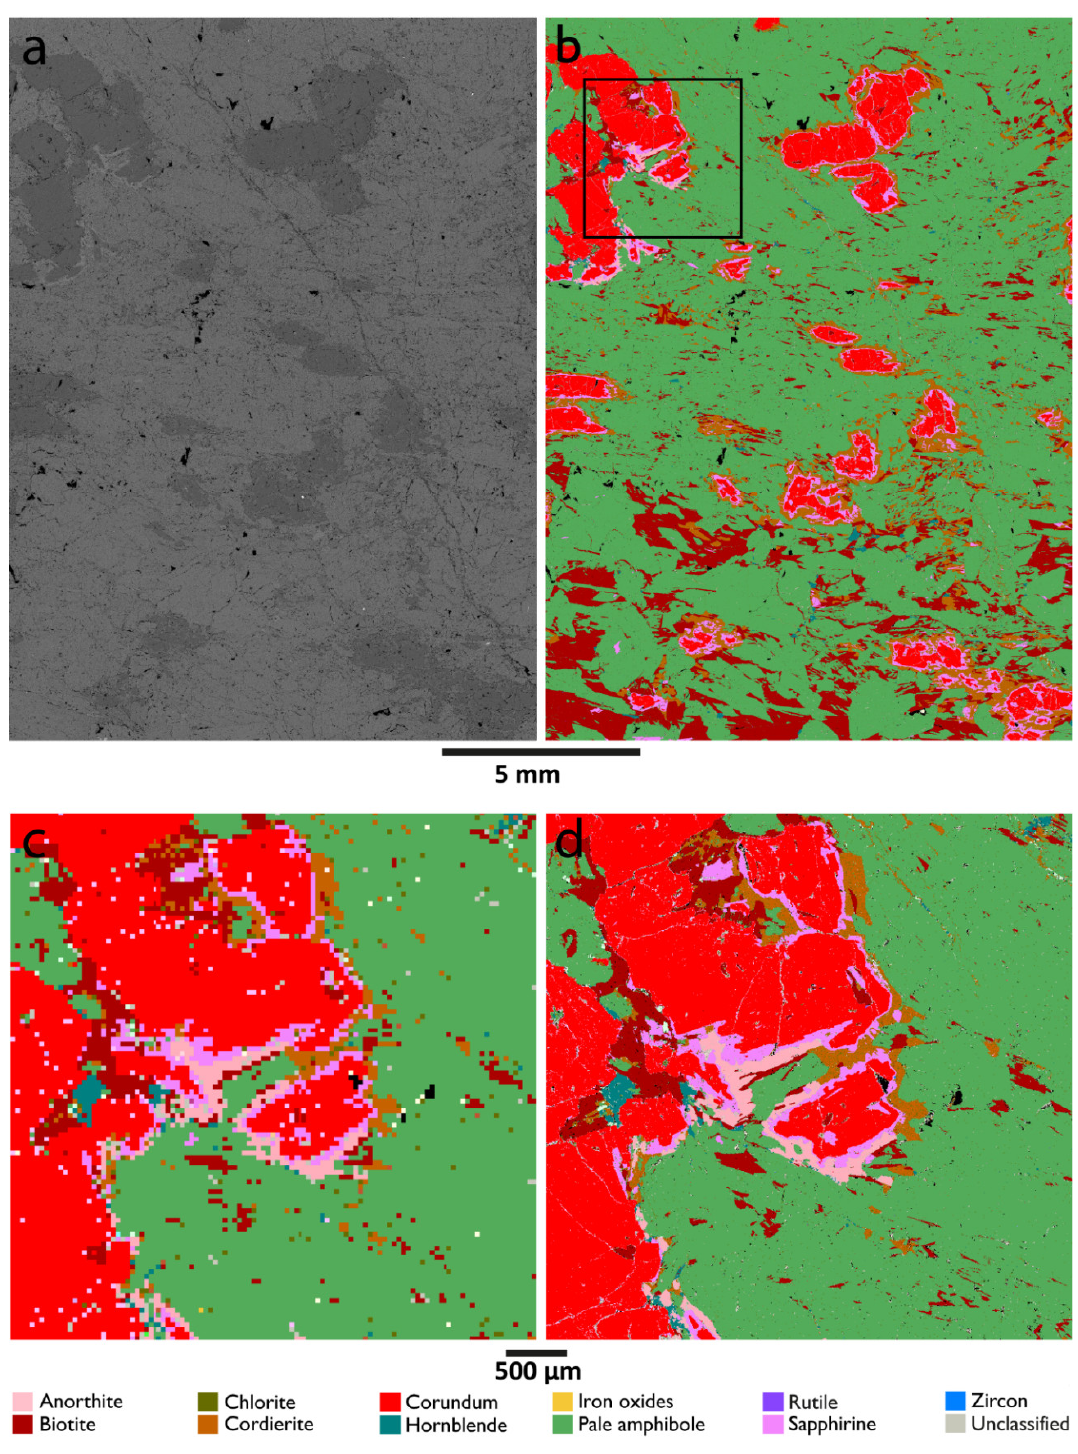
Figure 4. BSE and Mineral maps of sample 521106 and a selected area for comparing the map quality between different step sizes. ( a ) BSE image consisting of 220 frames. ( b ) 5 µm step size mineral map (ca. 9 million pixels). The square indicates the position of details in ( c , d ). ( c ) Selected area mapped with 40 µ m step size. ( d ) Selected area mapped with 5 µ m step size.